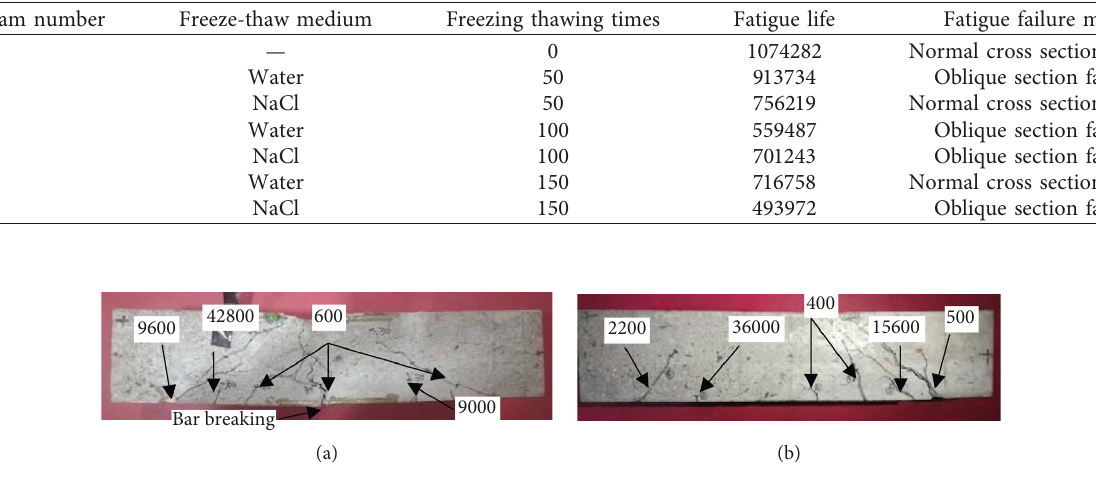
Figure 8: Fatigue failure mode of test beams. (a) Normal cross section failure. (b) Oblique section failure. Number in the fatigue means the number of cycles when each crack started to